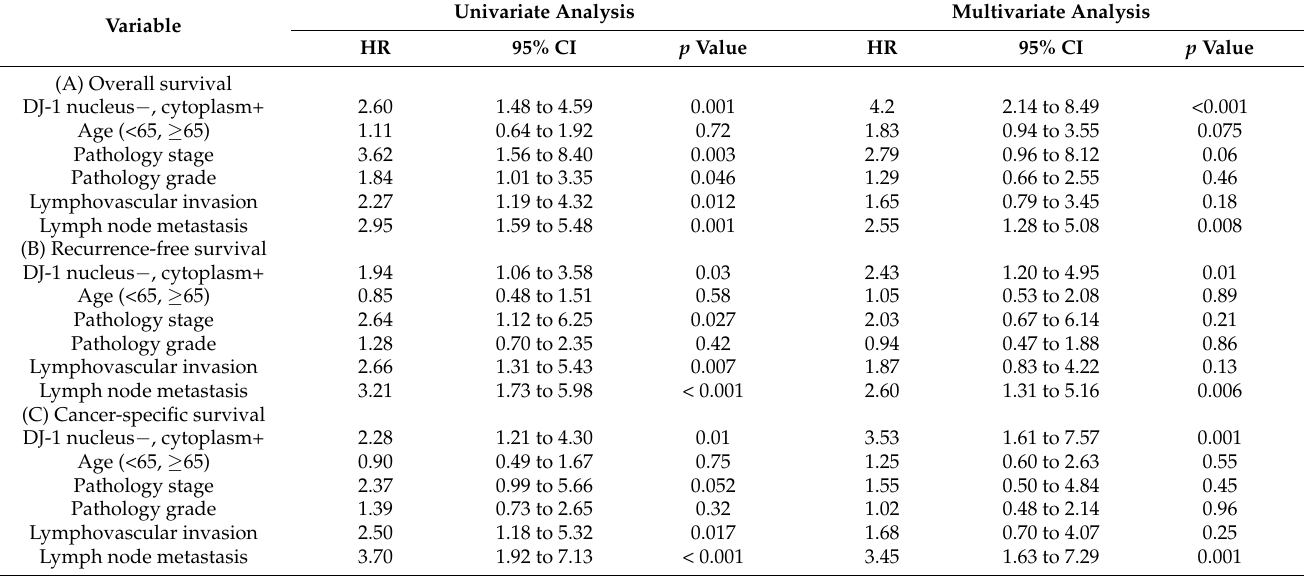
Table 3. Multivariate Cox proportional hazards regression analyses of DJ-1 expression and clinico- pathologic findings for predicting clinical outcome after radical